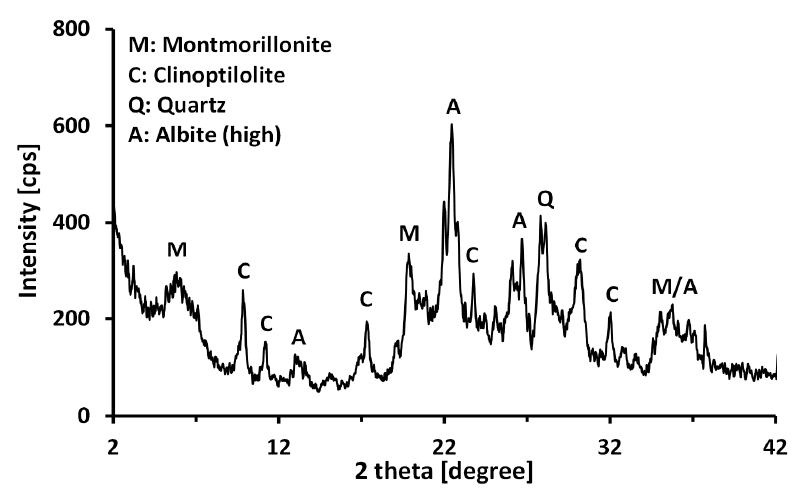
Figure 1. X-ray di ff raction (XRD) pattern of the calcium bentonite used in this Figure 1. X-ray diffraction (XRD) pattern of the calcium bentonite used in this study. Table 1. Chemical composition of the calcium bentonite.